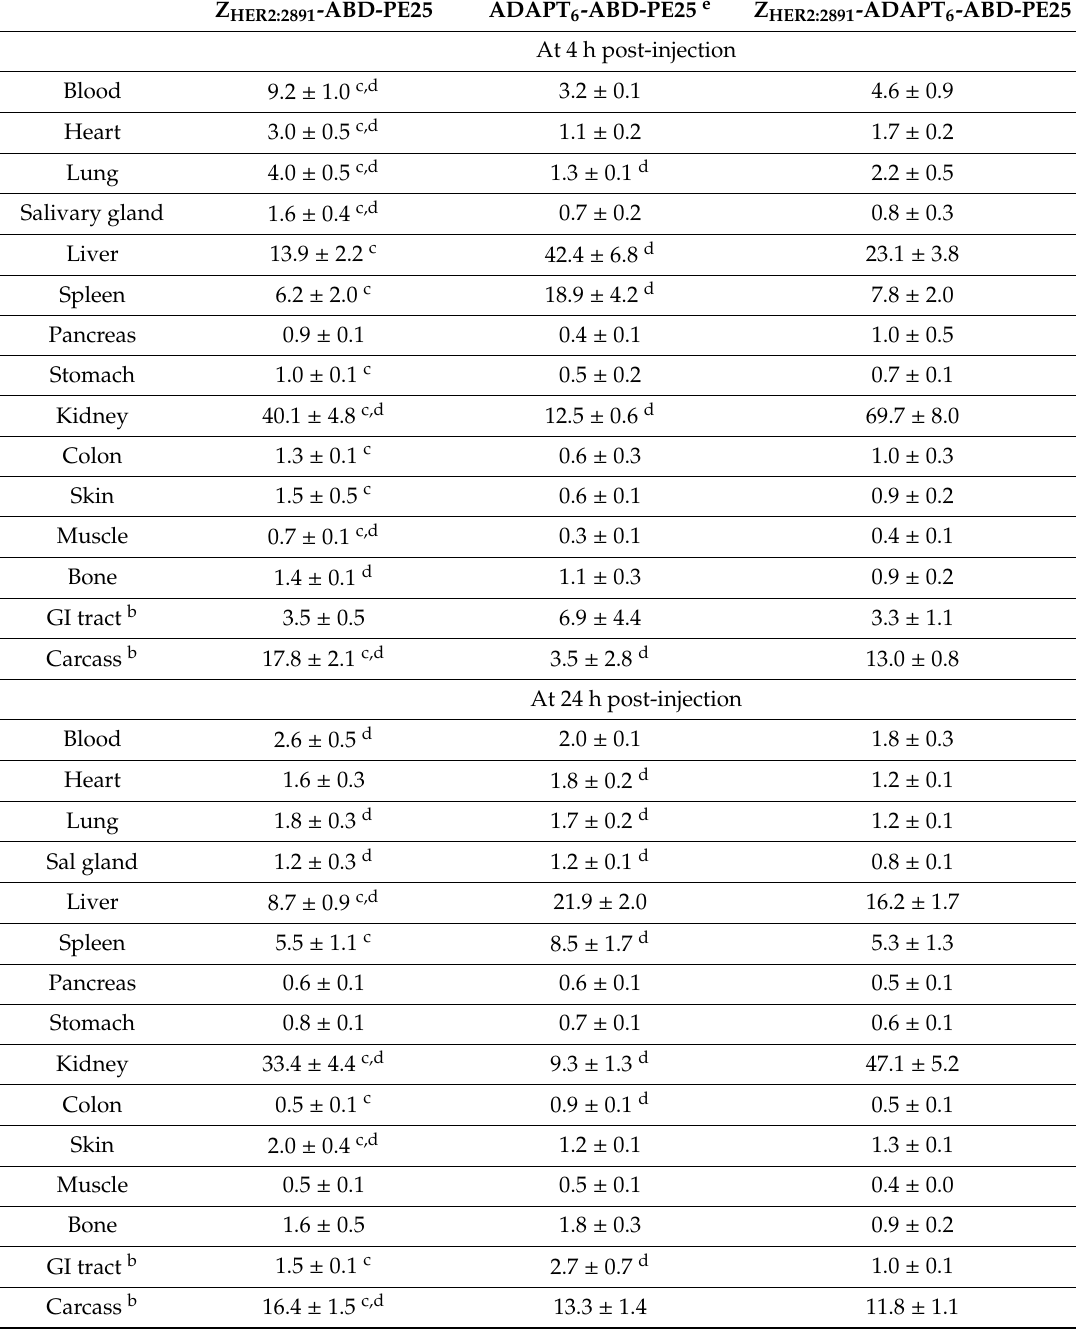
Table 1. Comparative biodistribution of the 111 In-labeled fusion toxins in mice 4 and 24 h following intravenous injection a